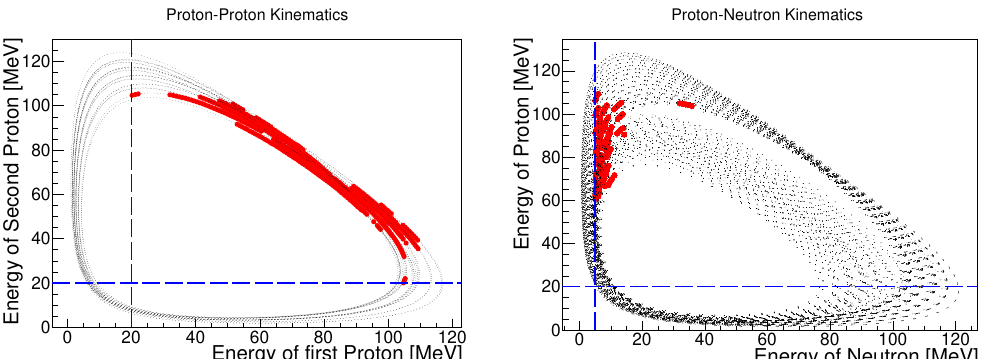
Figure 3: Left panel: A set of proton-proton kinematics for various combinations of θ , θ and ∆ φ angles (typical values for these angles are shown in Fig. 4). Red p 1 p 2 lines represent the regions, where the corresponding neutron can be detected in the BINA setup together with the proton-proton coincidences. Blue dashed lines refer to applied detection thresholds. Right panel: The same regions as in the left panel but for the neutron-proton kinematics.